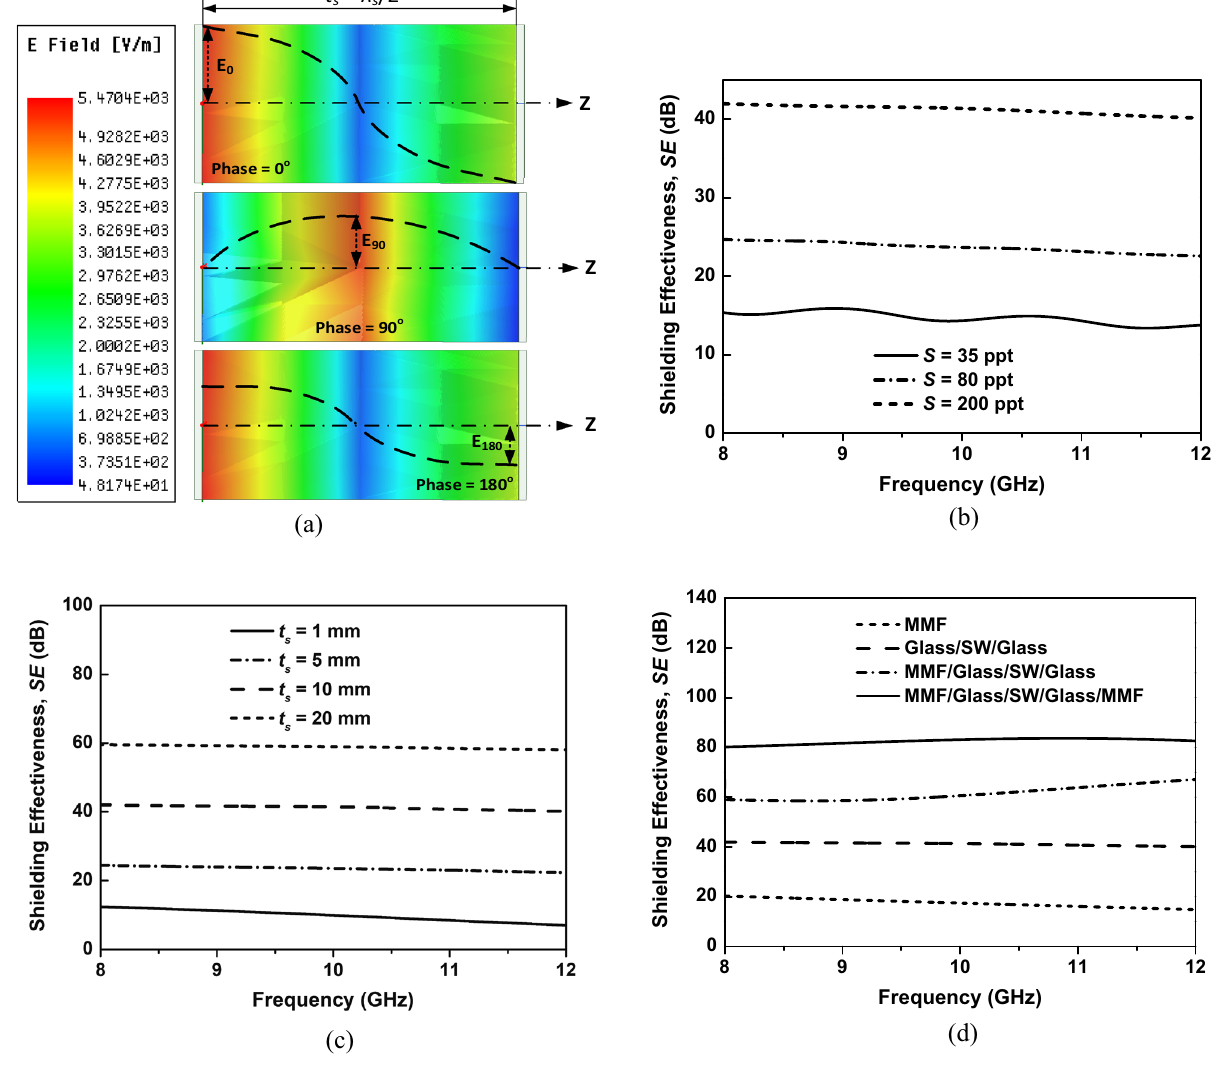
Figure 3. ( a ) E-field distribution of the incident EM wave along with the thickness of the saltwater layer with a thickness of a half wavelength of the EM wave in saltwater ( (cid:31) s ); SE of the planar saltwater in the C-band: ( b ) at different salinities ( t s = 10 mm), ( c ) at different thicknesses (S = 200 ppt); ( d ) SE of the four types of TEs in the